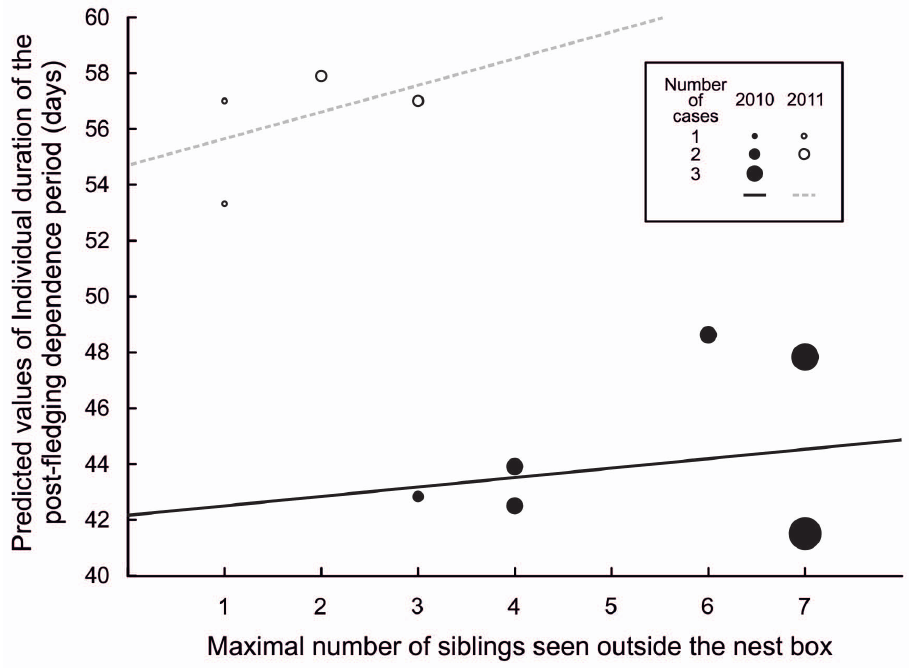
Figure 5. Predicted values of the individual duration of the post-fledging dependence period for 2010 (filled circles) and 2011 (open circles) plotted against the maximal number of siblings seen outside the nest box.